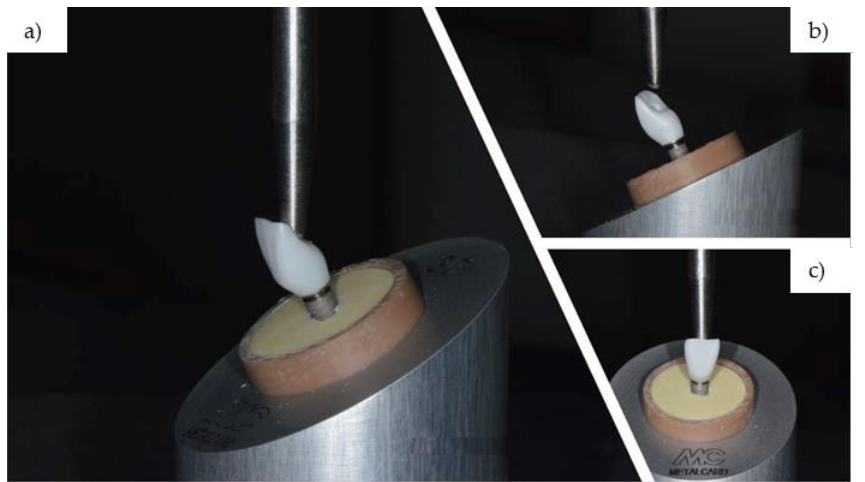
Figure 4. ( a ) Specimen fixed on a base with 30° of angulation about the ground (ISO 14801:2016); ( b ) and ( c ) Specimen being submitted to a compressive load of 0.5 mm/min in a universal testing ma- chine.